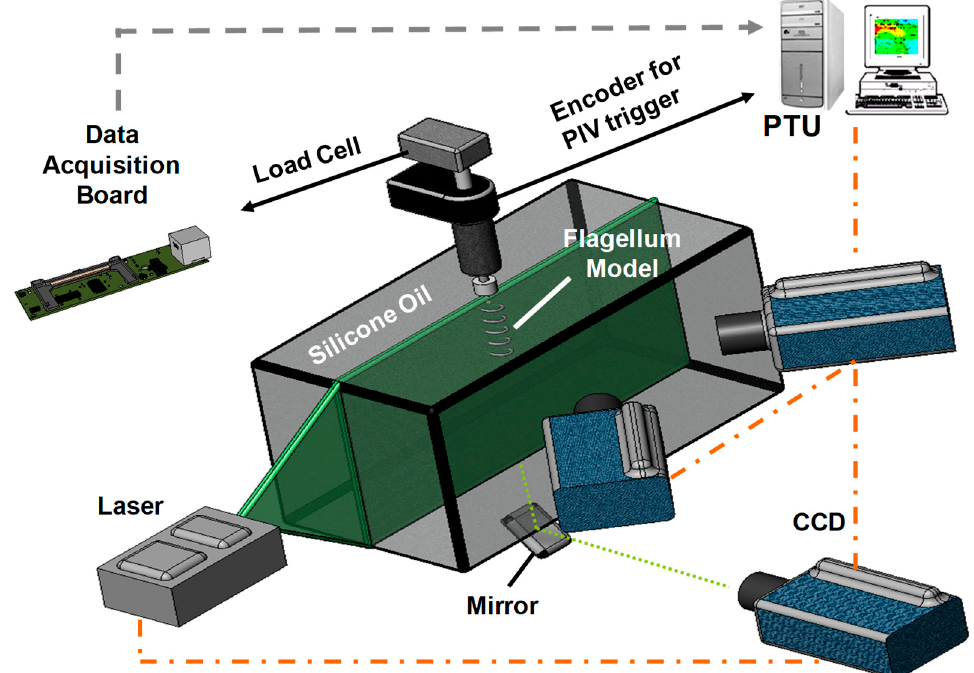
Figure 1. The graphic of the experimental set-up. Only the axial laser sheet configuration is displayed while the lateral 3D particle image velocimetry (PIV) data is acquired for validation and verification purposes using the mirror. PTU: Pulse timing unit.